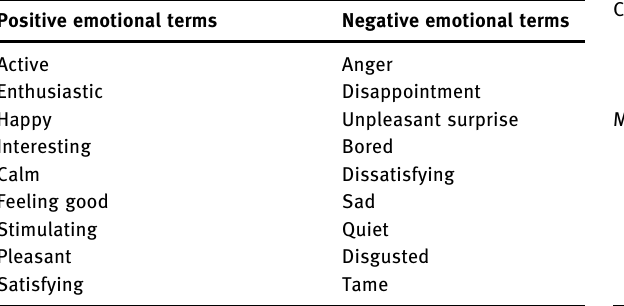
Table 2: The selected emotional terms Positive emotional terms Negative emotional terms